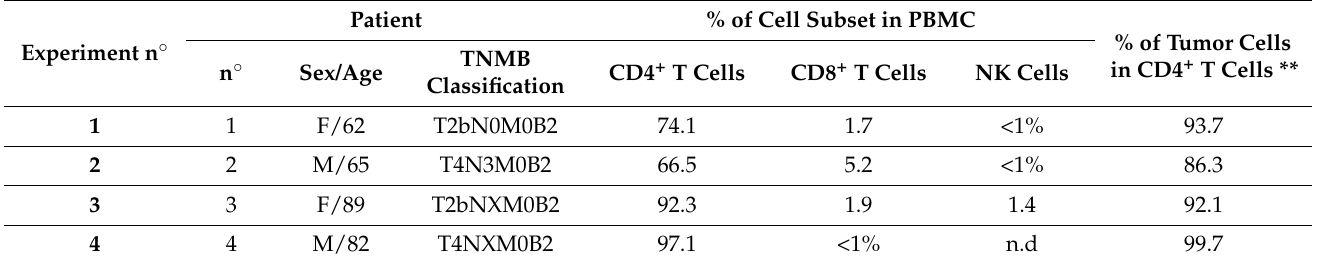
Table 1. S é zary patients’ main features and lymphocytes content prior to engraftment